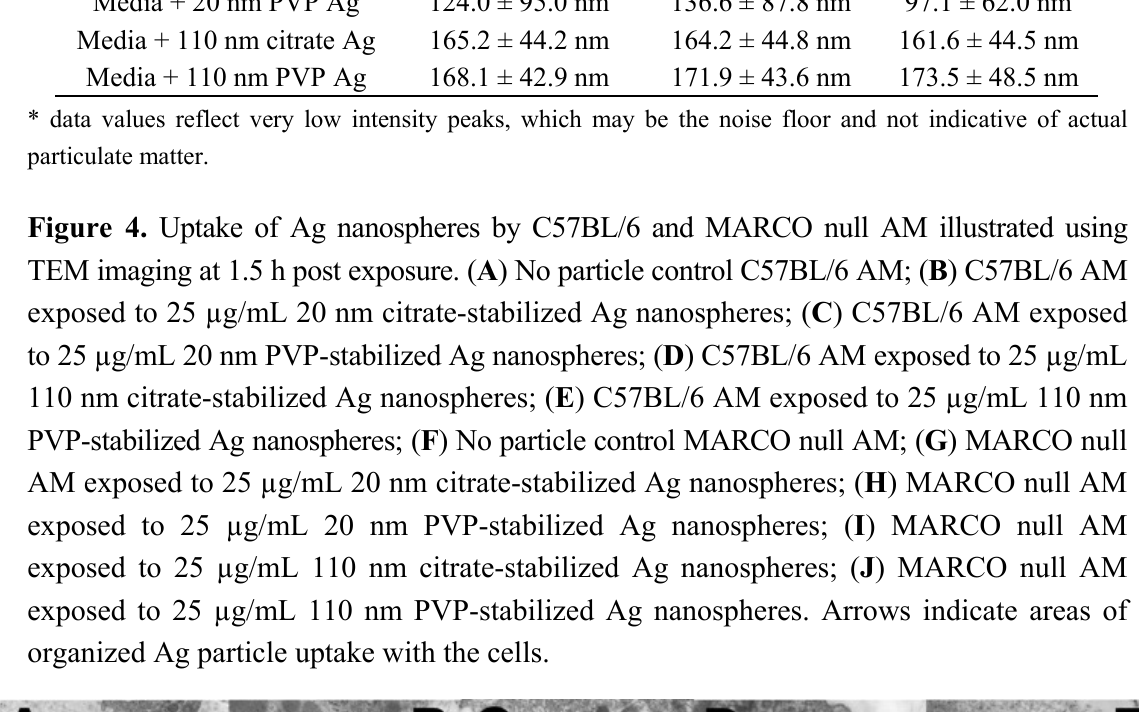
Table 1. Aggregation state of Ag nanospheres in RPMI culture medium with variable serum concentrations by DLS. Data are mean hydrodynamic diameter (nm) ± range (nm).